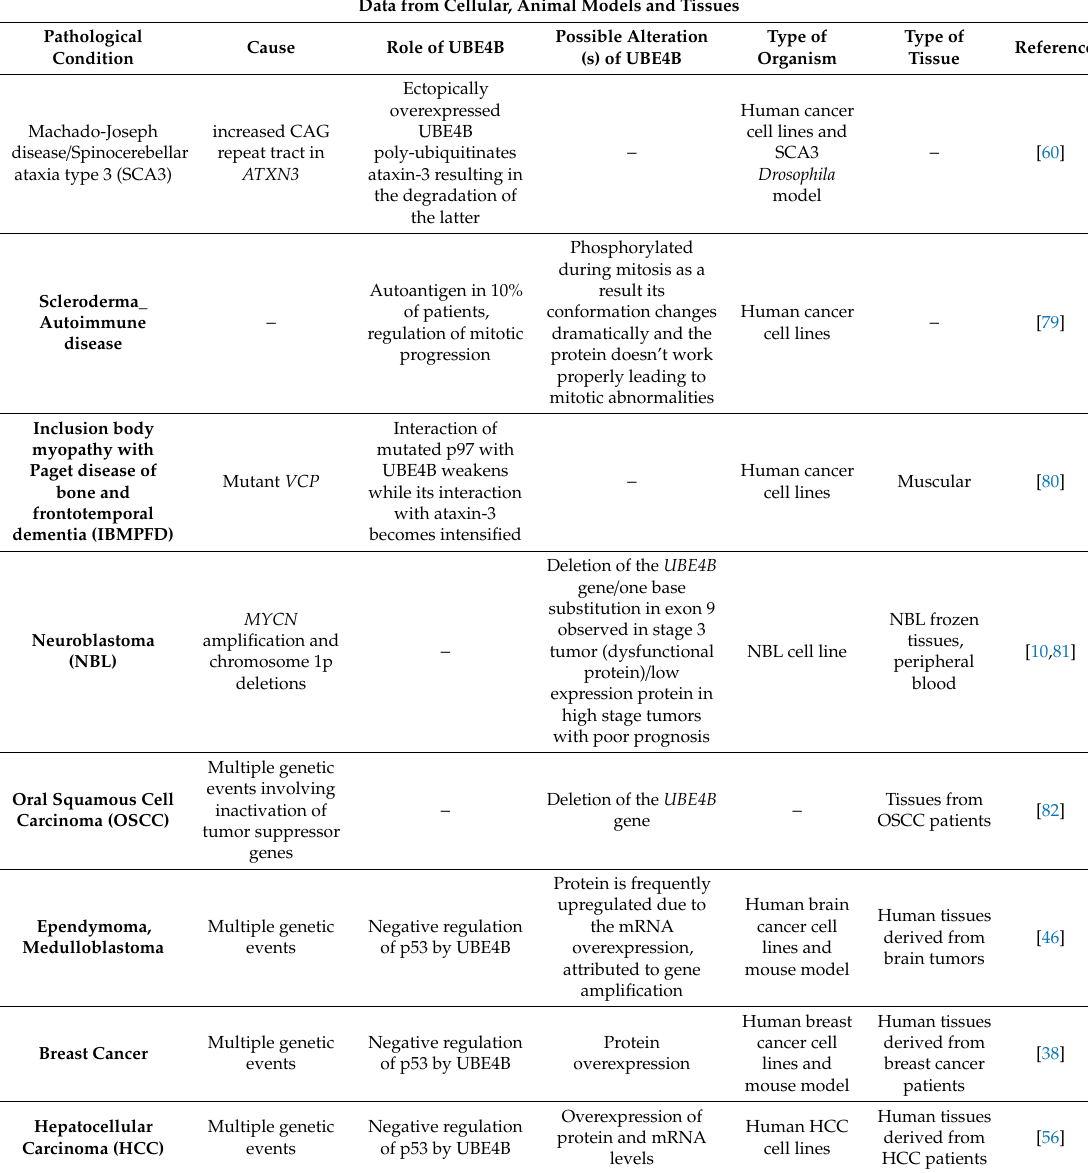
Table 1. UBE4B in human